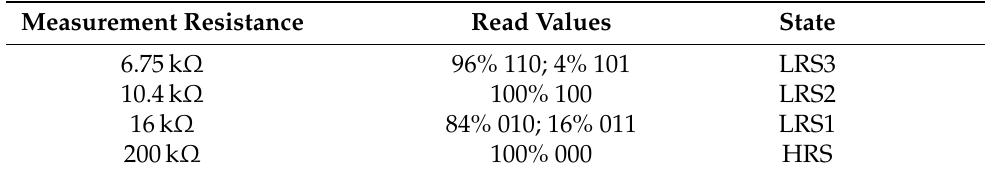
Table 4. Read system measurement results.